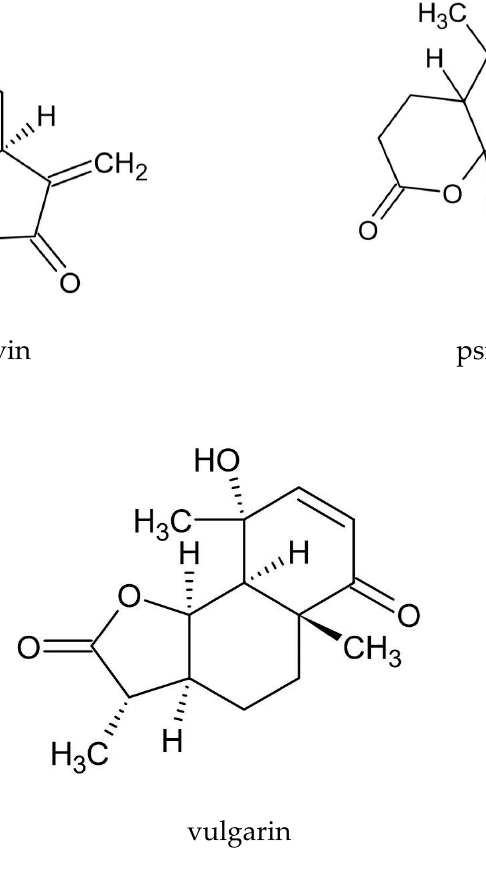
Figure 1. The chemical structure of sesquiterpenoid lactones characteristic of A. vulgaris. Table 2. The chemical composition of A. vulgaris aerial parts.